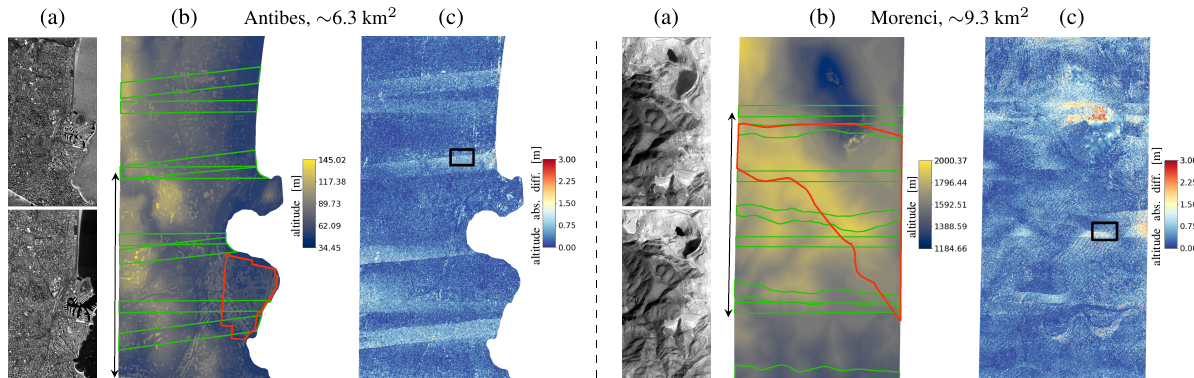
Figure 5. Qualitative results for SkySat stereo reconstruction, using 5 scenes from the input strips, i.e. N = 5. Left to right: (a) L1B + images. (b) L1B + derived DSMs. The size of the reconstructed area is indicated in square kilometers. The red boundary delimits the region for which a lidar model is available. The green boundaries delimit the regions of overlap between two local models used to derive the equivalent L1B DSM. The double-headed arrow indicates the length covered in the experiments with N = 3. (c) Absolute difference between the L1B + and L1B DSMs. The black rectangular outline delimits a subregion of interest inspected in Figure 6. MAE [m]